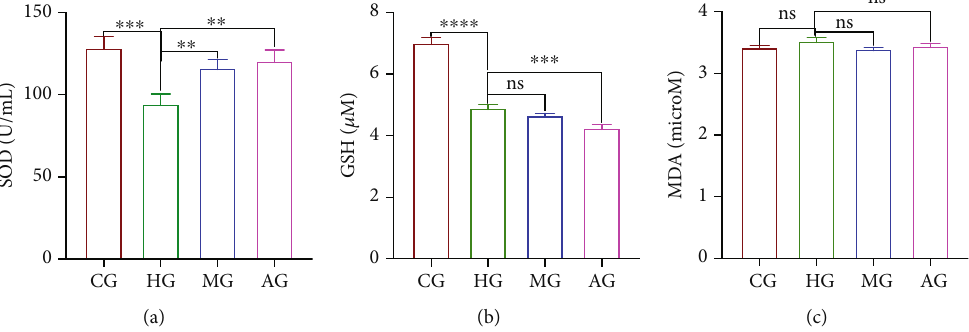
Figure 6: The levels of oxidative factors. (a) Serum SOD. (b) Serum GSH. (c) Serum MDA. n = 3 for each group, and ns P > 0 : 05 , ∗∗ P < 0 : 01 , ∗∗∗ P < 0 : 001 , and ∗∗∗∗ P < 0 : 0001 vs. the HG